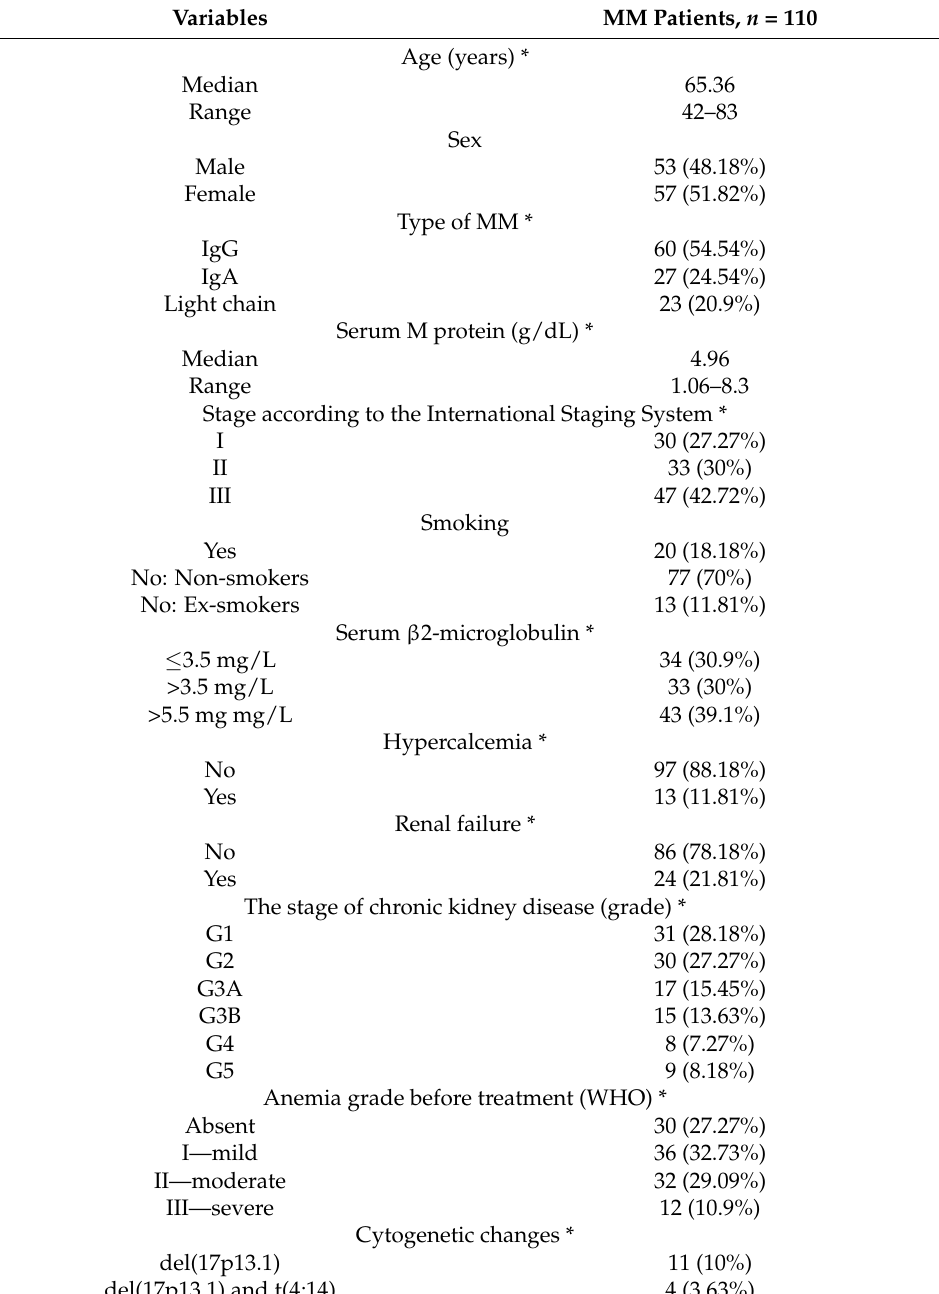
Table 1. The characteristics of MM patients included to the